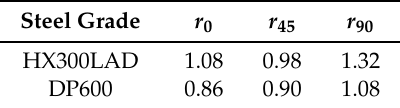
Table 1. Lankford’s parameters due to anisotropic behavior.